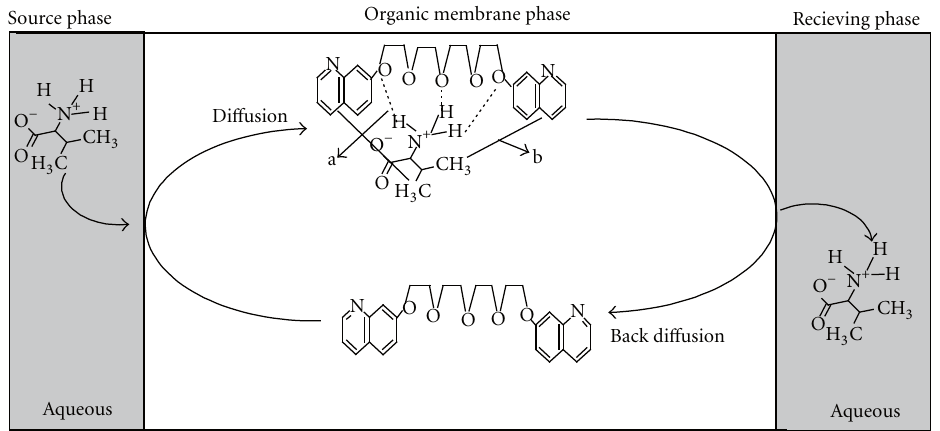
F 9: Schematic representation of liquid membrane studies of amino acids using krypto�x 5 as carrier in chloroform liquid membrane system. AA means amino acid. (a) represents interaction between –NH alkyl part of amino acid and electrons of krypto�x5. Π